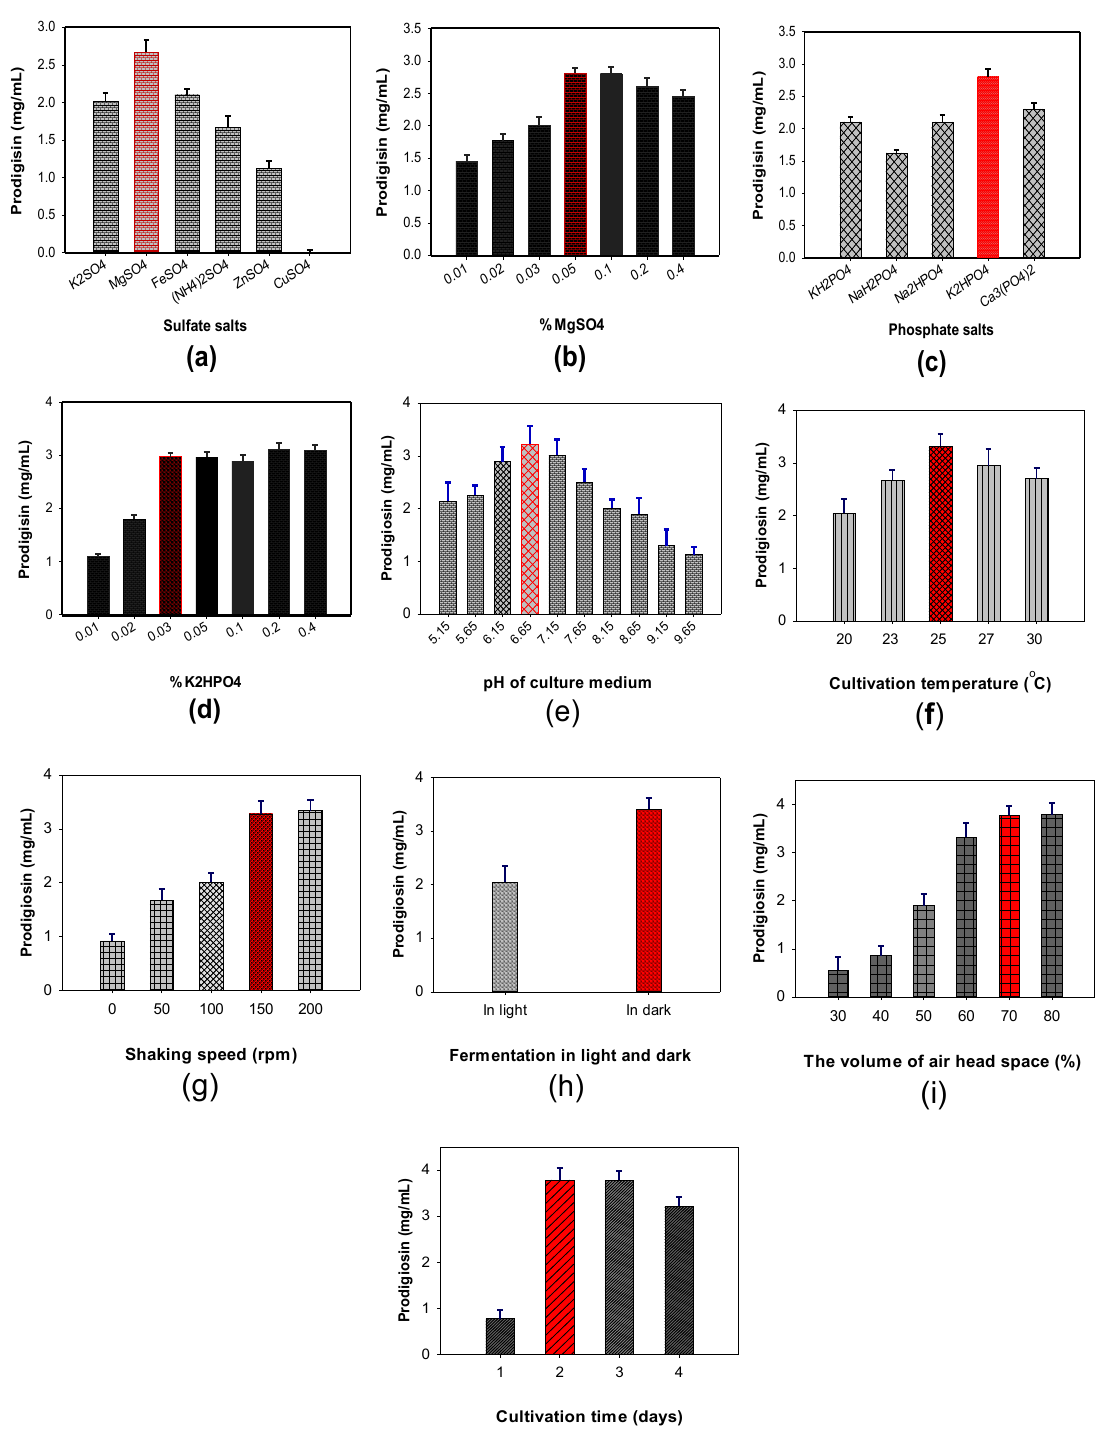
Figure 3. The effect of sulfate salts ( a ), added MgSO 4 ( b ), phosphate salts ( c ), and added K 2 HPO 4 ( d ), initial pH of the medium ( e ), cultivation temperature ( f ), shaking speed ( g ), fermentation in light (no cover the flask) or in dark (cover the flask) ( h ), the volume of air headspace percentage ( i ), and cultivation time ( j ) on PG production by S. marcescens TNU01.